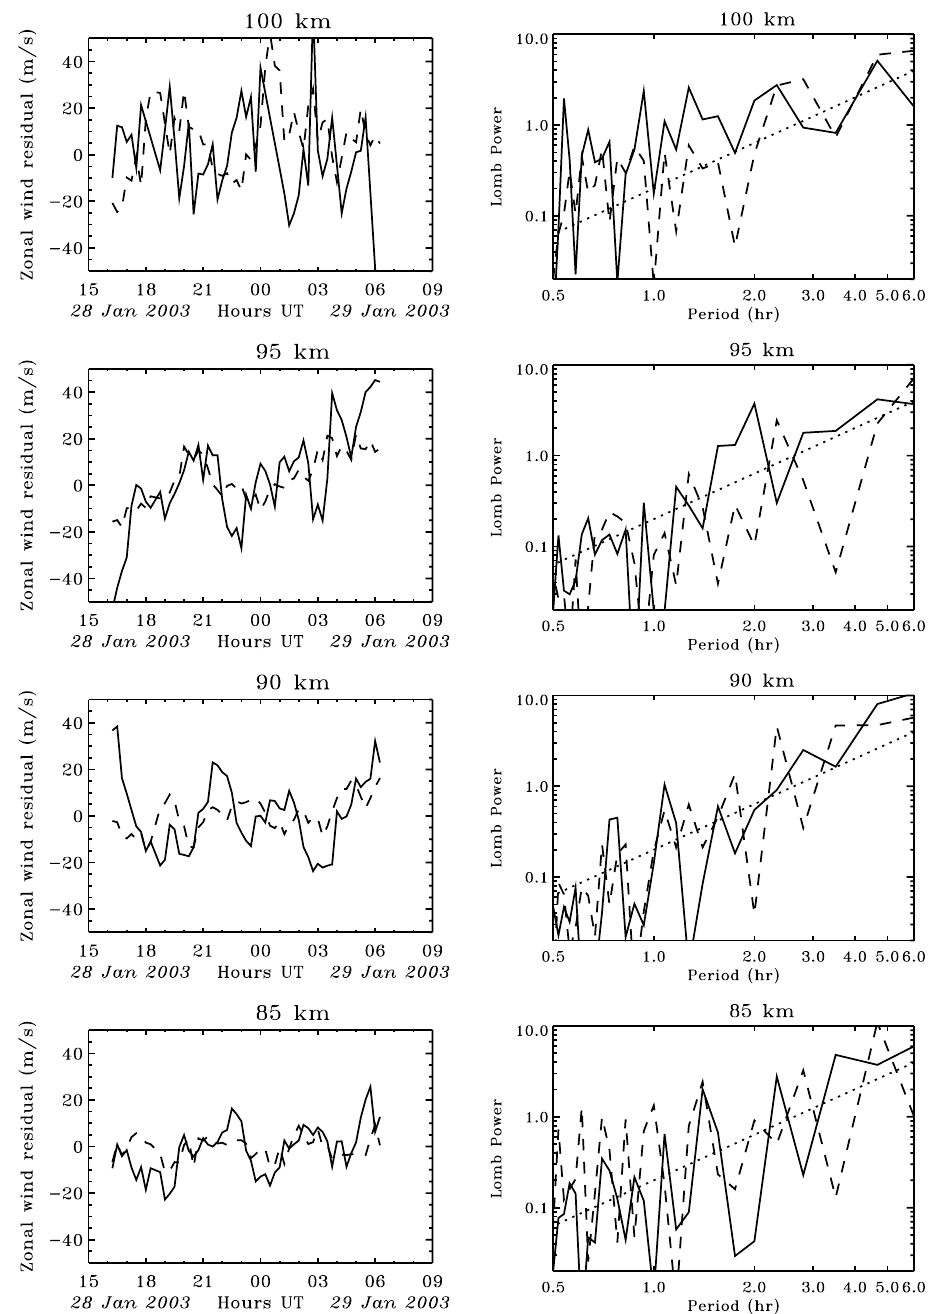
Fig. 6. Left column: Residual temperature (dash) and zonal wind (solid) perturbations after subtraction of semidiurnal tide. Right column: Lomb spectra for zonal wind (solid) and temperature (dash) residual and dotted line indicating a –5/3